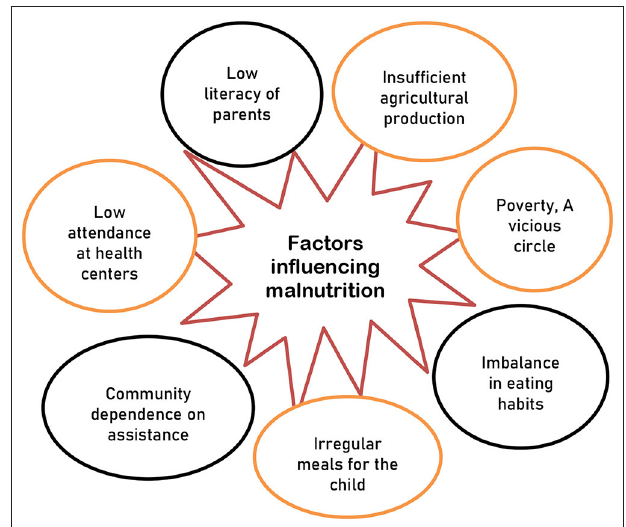
FIGURE 1 | Factors influencing